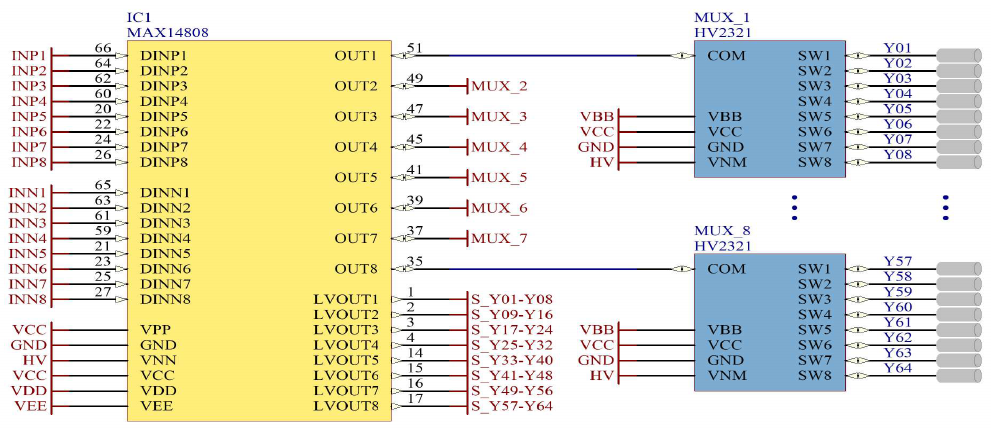
Figure 5. HV pulser device and multiplexer for 64 piezoelectric transducers.